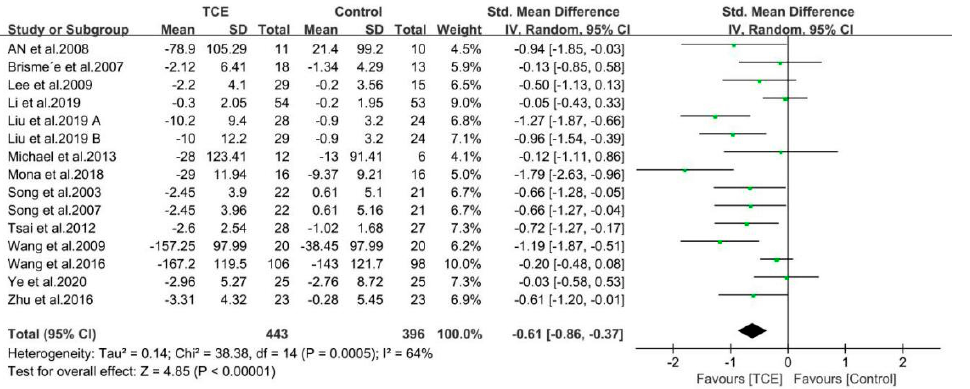
Figure 4. Forest plots showing standardized mean difference of change on the pain score (WOMAC/KOOS) between traditional Chinese exercise (TCE) group and a control/comparison group. CI: Confidence Interval; KOOS: The Knee Injury and Osteoarthritis Outcome Score; WOMAC: